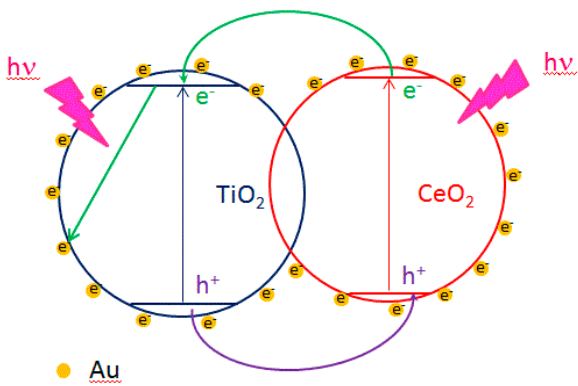
Figure 7. Scheme of the electron transfer phenomena taking place in the Au/TiO 2 -CeO 2 system by irradiation with UV light.